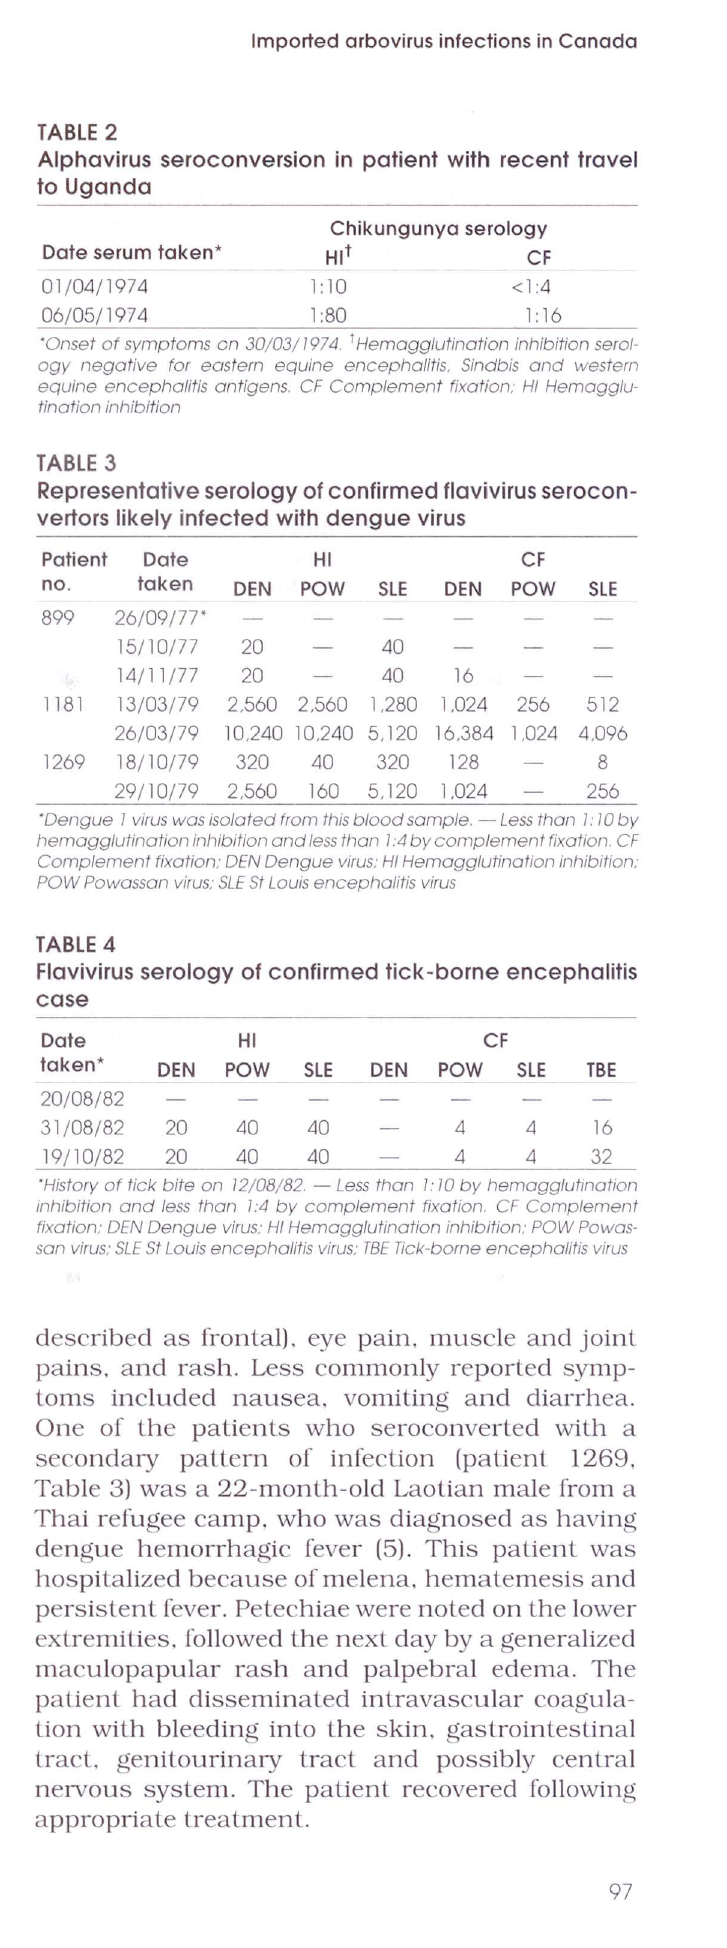
Alphavirus seroconversion in patient with recent travel to Uganda